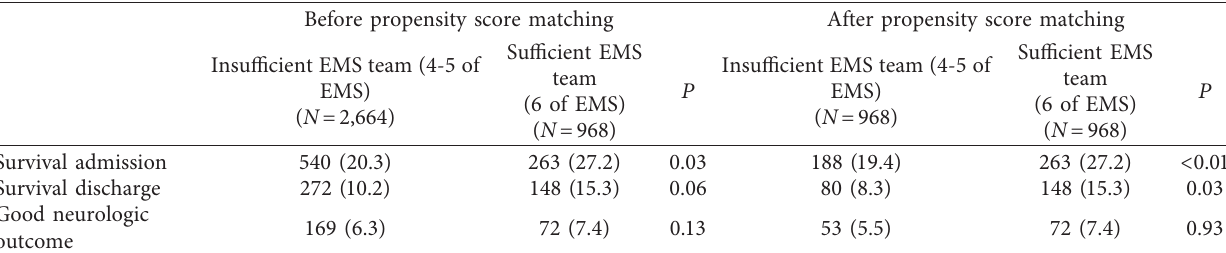
Table 2: Outcomes before and after propensity score matching.